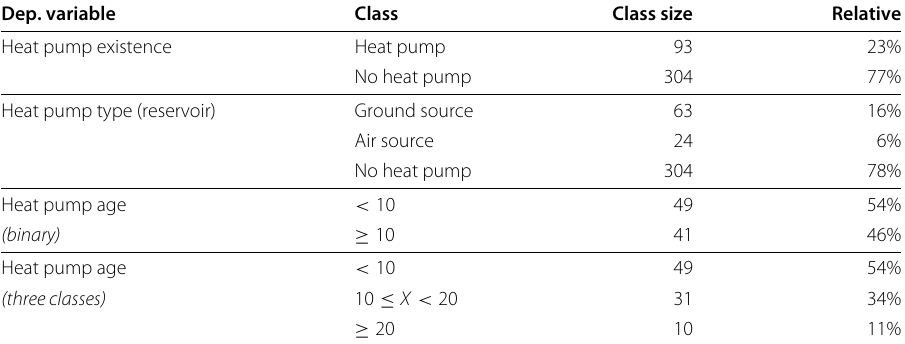
Table 1 Heat pump characteristics and available ground truth data Dep.